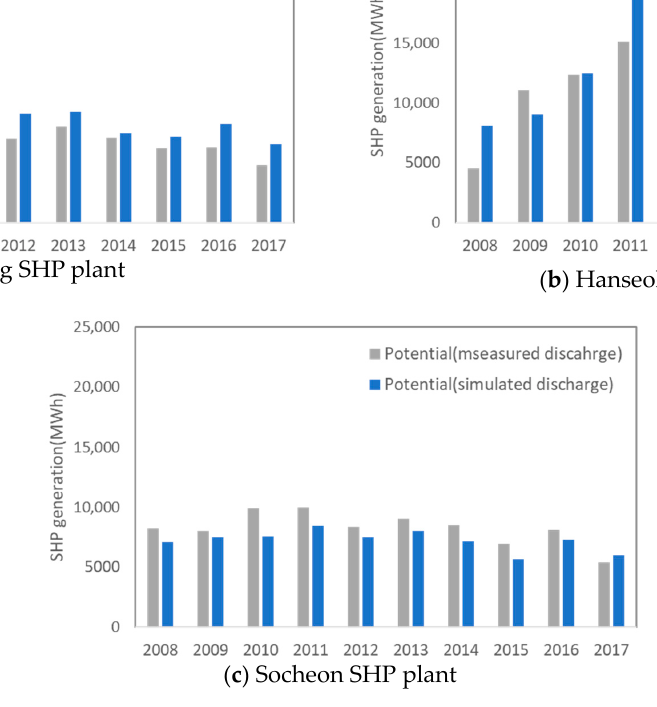
Figure 6. Annual SHP potential. Figure 6. The comparison results between the simulated and measured SHP